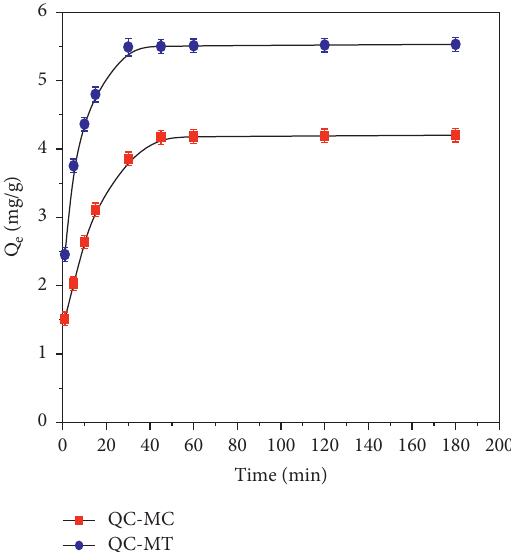
Figure 3: Effect of contact time of Cd (II) on QC-MC and QC-MT ( C 0 � 10mg/L, T � 25 ° C, m � 1.5 g, V � 100mL, and pH � 5).